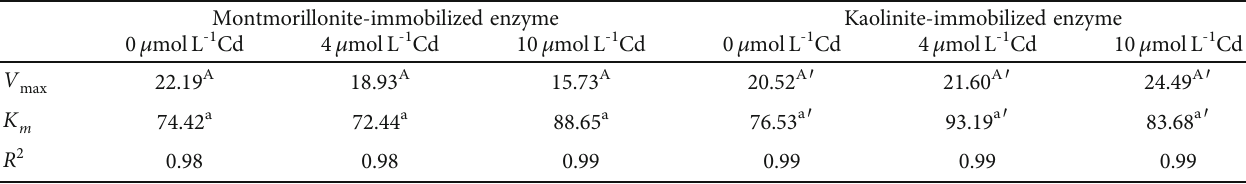
Figure 8: E ff ect of Cd on the kinetics curves of montmorillonite-immobilized LAP and kaolinite-immobilized LAP. Table 4: Changes in the kinetic constants ( V and K m ) of montmorillonite-immobilized LAP and kaolinite-immobilized LAP with 0, 4, max and 10 μ molL -1 Cd